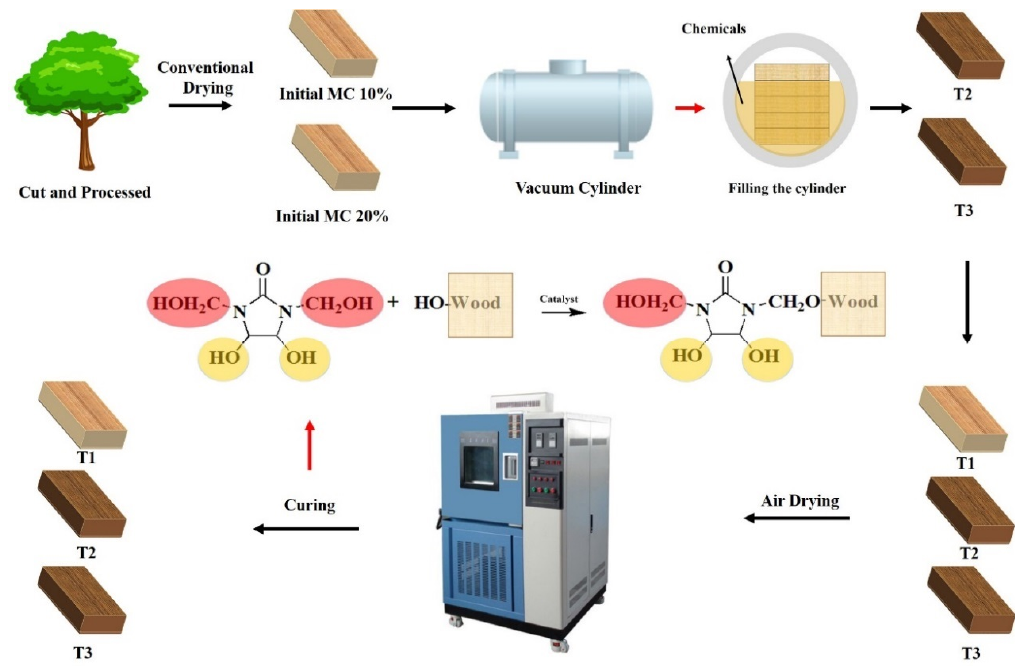
Figure 1. Experimental technology roadmap. T1 represents the untreated materials, T2 represents the impregnated materials with 10% initial moisture content (MC); and T3 represents the impregnated materials with 20% initial MC . Table 1. Drying schedule of different treated poplar wood. MC: moisture content; RH: relative humidity. MC/% Dry bulb/°C Wet bulb/°C RH/% Preheating 35 35 100